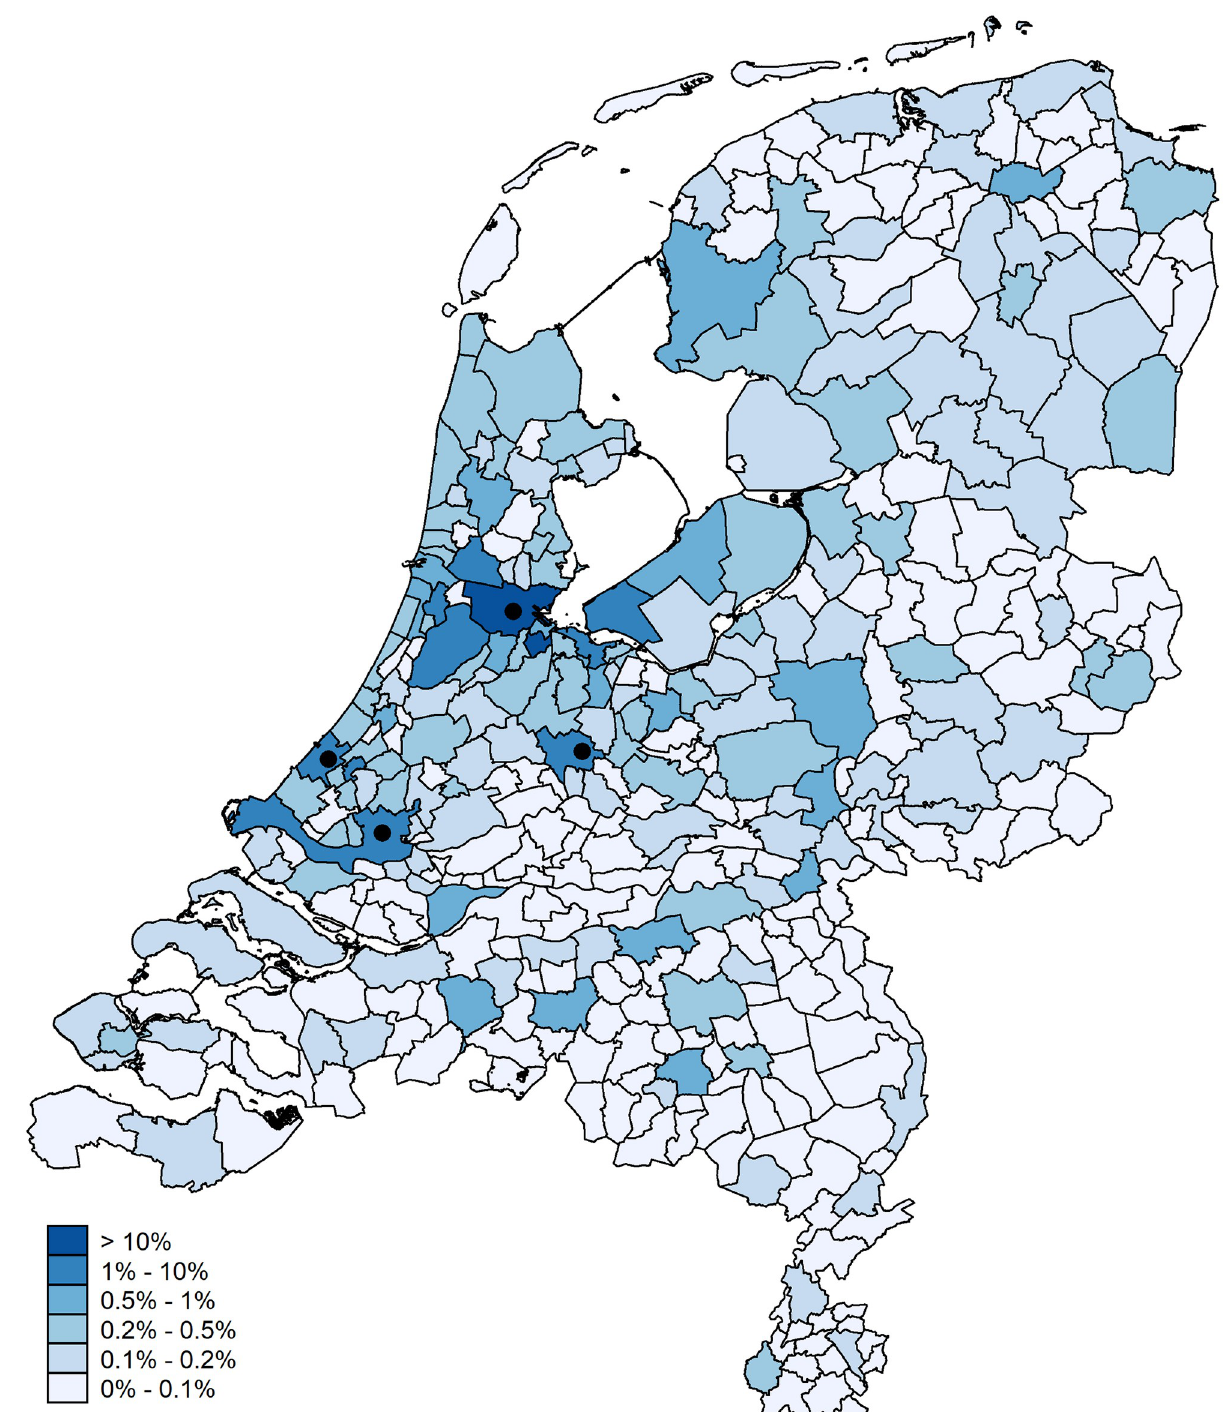
Fig 1. Hits from Amsterdam. Digital geometry (i.e., the shapefile) obtained from CBS/Kadaster [30]).